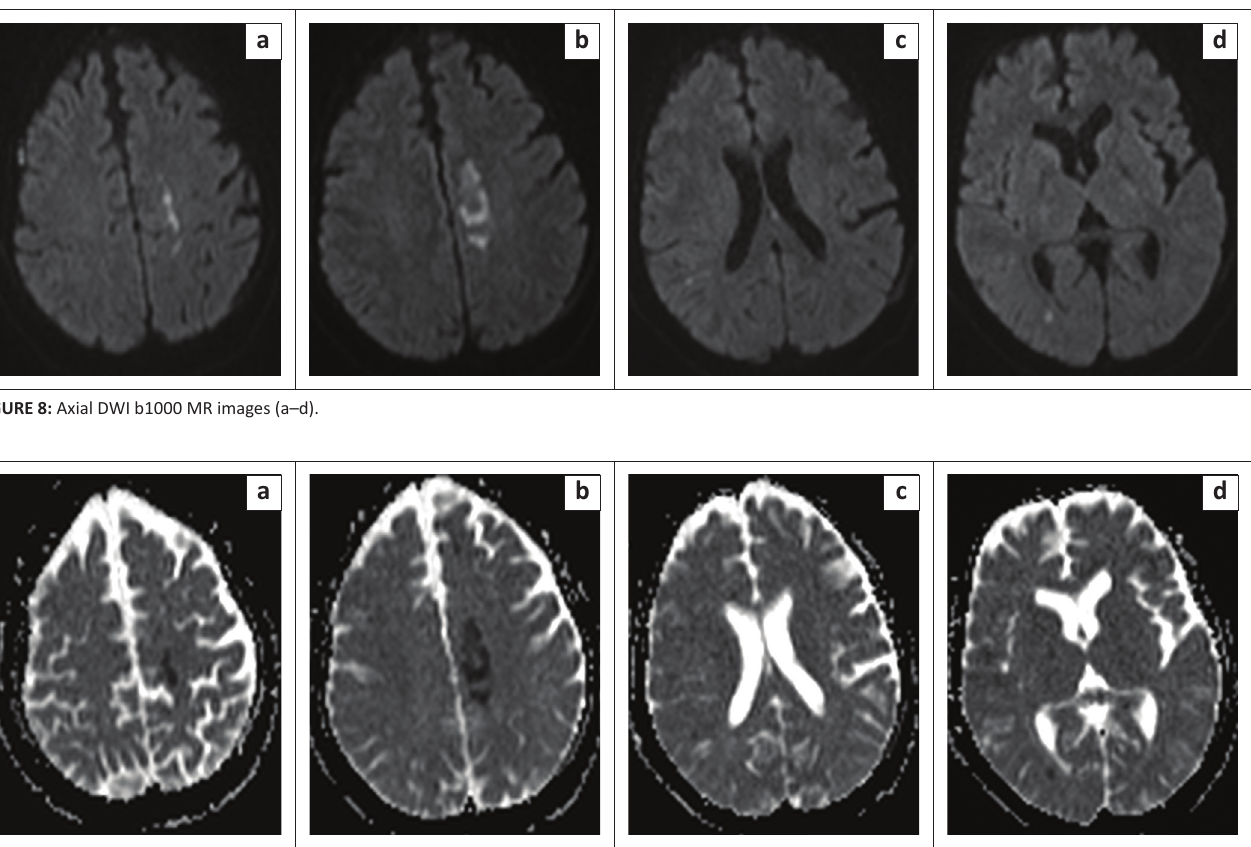
FIGURE 9: Corresponding axial ADC map MR images (a–d).